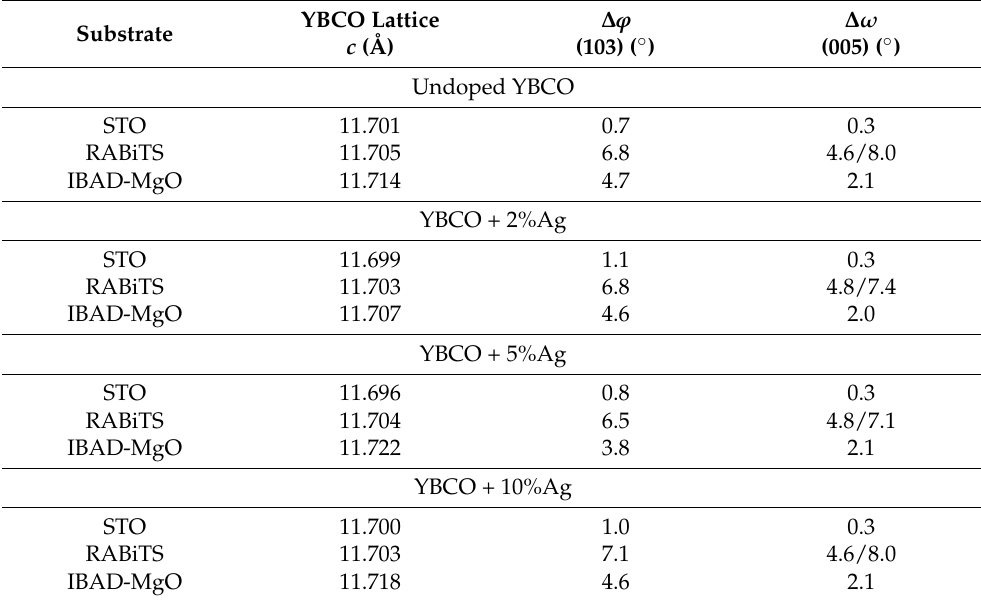
Table 2. Structural parameters determined from XRD measurements for undoped and Ag − doped YBCO films grown on different templates. For the RABiTS templates, the first value for ∆ ω is along the rolling direction and the second perpendicular to